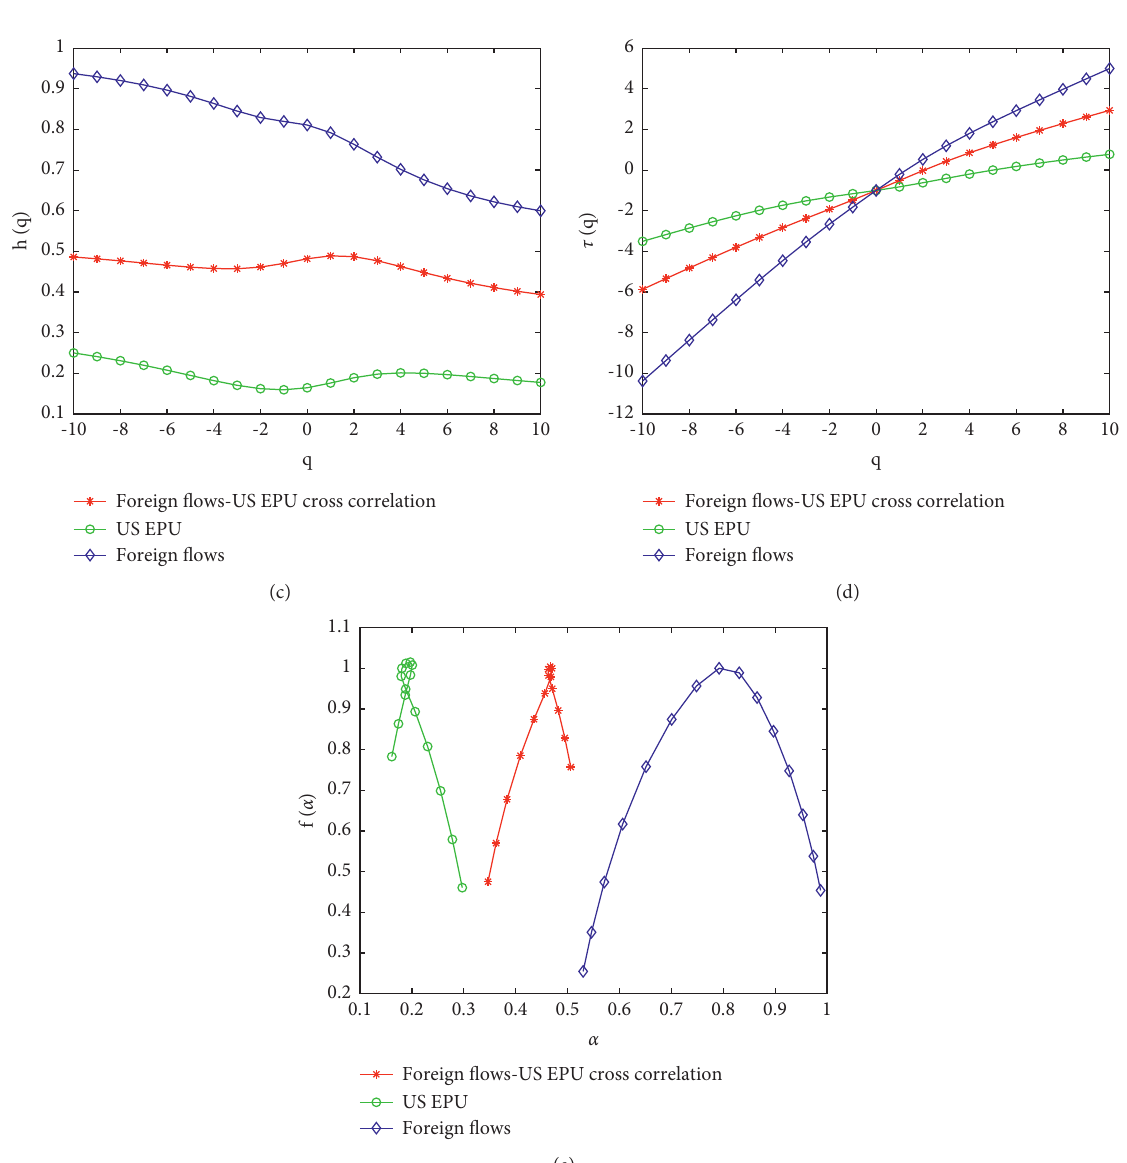
Figure 12: Cross-correlation analysis and MF-DCCA analysis between the foreign flows after the implementation of Shenzhen-Hong Kong Stock Connect and US EPU index. (a) Cross-correlation statistics Q cc ( m ) . (b) Log-log plots of F q ( s ) versus s . (c) Generalized Hurst exponent of H ( q ) versus q . (d) Renyi exponent of τ ( q ) versus q . (e) Multifractal spectrum f ( α ) versus α